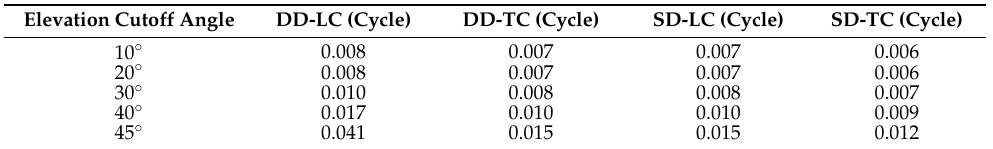
Figure 6. The ADOP series of the DD-LC, DD-TC, SD-LC, and SD-TC models under a 45° elevation cutoff angle in the multi-epoch solution. Table 7. The mean ADOP values of the DD-LC, DD-TC, SD-LC, and SD-TC models under different elevation cutoff angles in the multi-epoch solution.